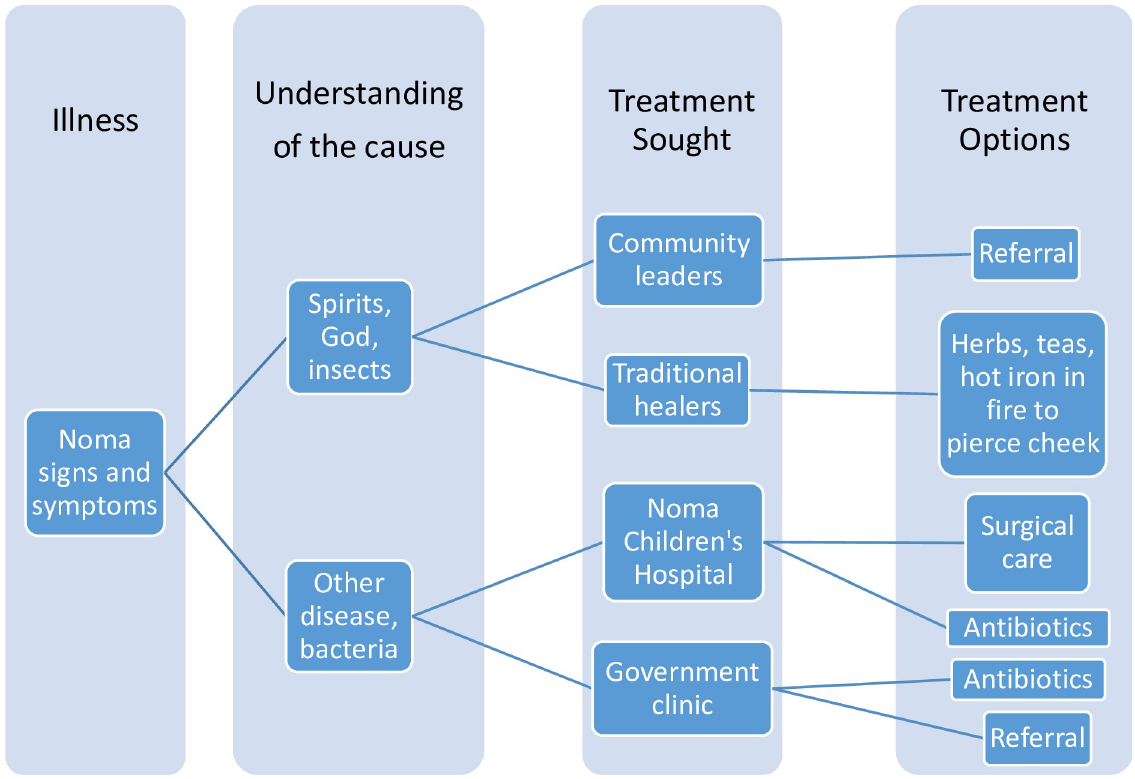
Fig 2. Explanatory model for noma. Knowledge and beliefs about the disease affect health seeking treatment decisions.